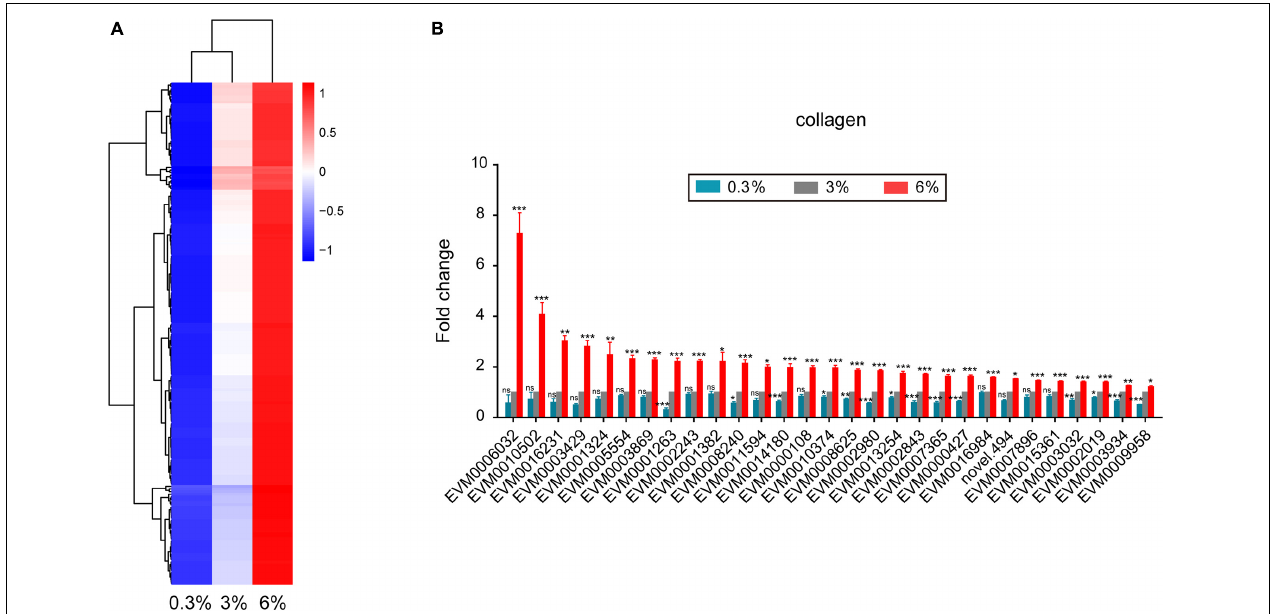
FIGURE 5 | Genes that up-regulated in expression with increasing salinity. (A) Hierarchical clustering of 192 DEGs that up-regulated in expression with increasing salinity, performed using the pheatmap package in R. | log2foldchange| > 0; DESeq2 padj < 0.05 was set as the differential gene screening threshold. Relative expression levels (z-score, log-transformed gene expression level based on FPKM value) were indicated for each gene (row) in each sample (column). Red indicates upregulation; blue indicates downregulation. The scale bar shows the z-score for a differentially expressed gene. (B) Expression level of cuticle collagen genes. Fold change indicates the ratio of FPKM value of the treatment group (0.3%, 6%, as indicated) to that of the control group (3%). The error bars represent standard error of the mean of three biological replicates per condition. The comparisons between the treatment and control groups were analyzed statistically using the Benjamini and Hochberg’s methods calculated by DESeq2. The value of padj < 0.05 was considered statistically significant. *padj < 0.05, **padj < 0.01, ***padj < 0.001, ns–not